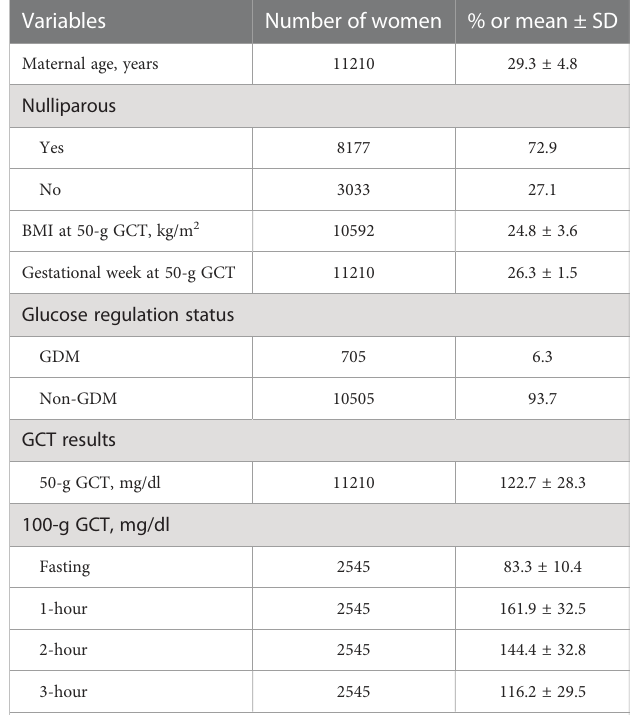
TABLE 1 Characteristics of the study population.